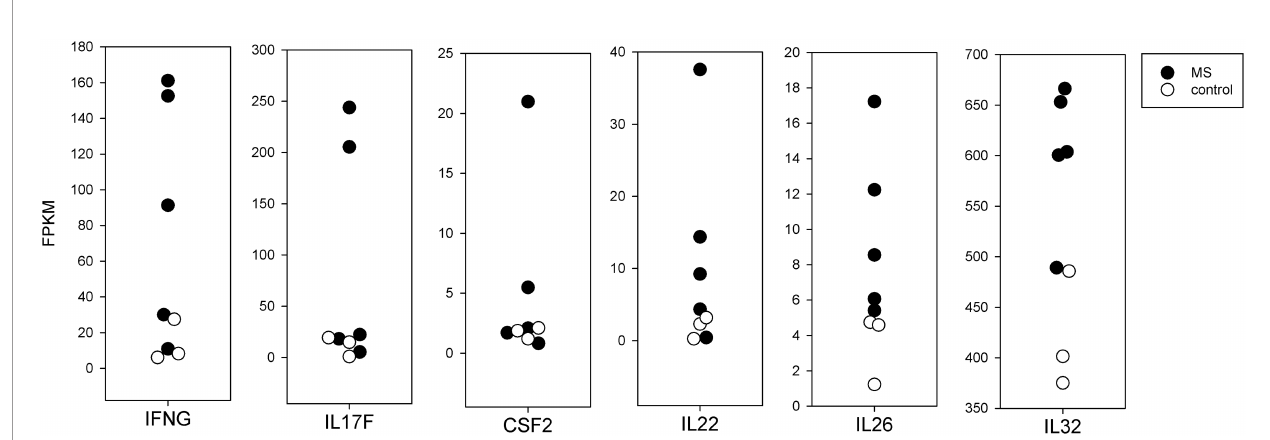
FIGURE 4 | Expression of selected cytokine mRNA in brain-stimulated cells from MS and controls.